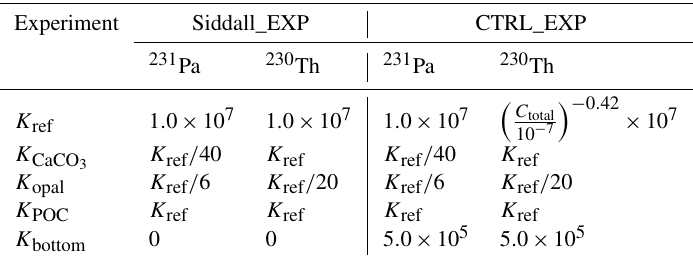
Table 2. Equilibrium partition coefficients in experiments Siddall_EXP and